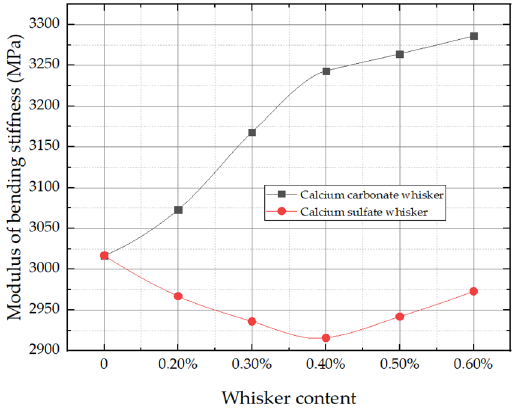
Figure 6. Bending stiffness modulus test results.